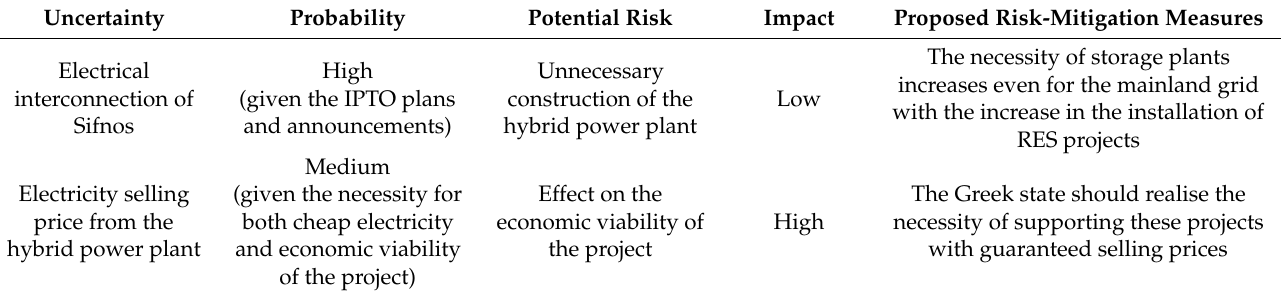
Table 6. Summary and evaluation of the uncertainties on the hybrid power plant